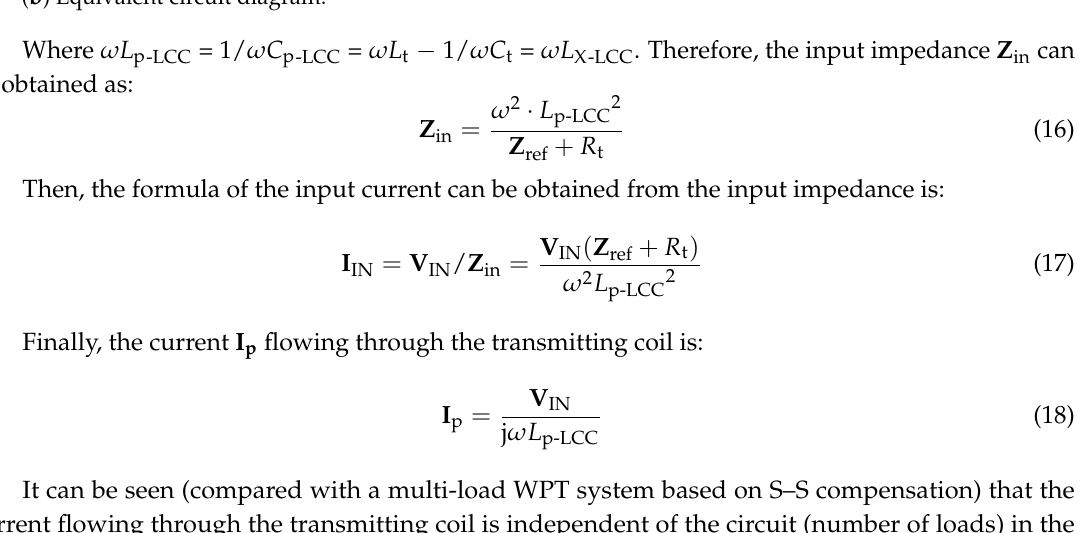
Figure 6. A multi-load WPT system based on an LCC topology. ( a ) System circuit diagram. ( b ) Equivalent circuit